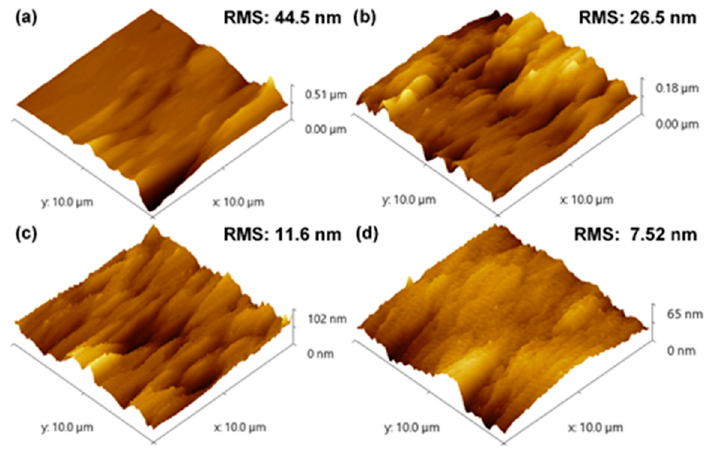
Figure 5. Atomic force microscopy (AFM) measurement of AlGaN grown on an NPSS at growth times of ( a ) 5; ( b ) 10; ( c ) 20 and ( d ) 30 min. RMS: root-mean-square.